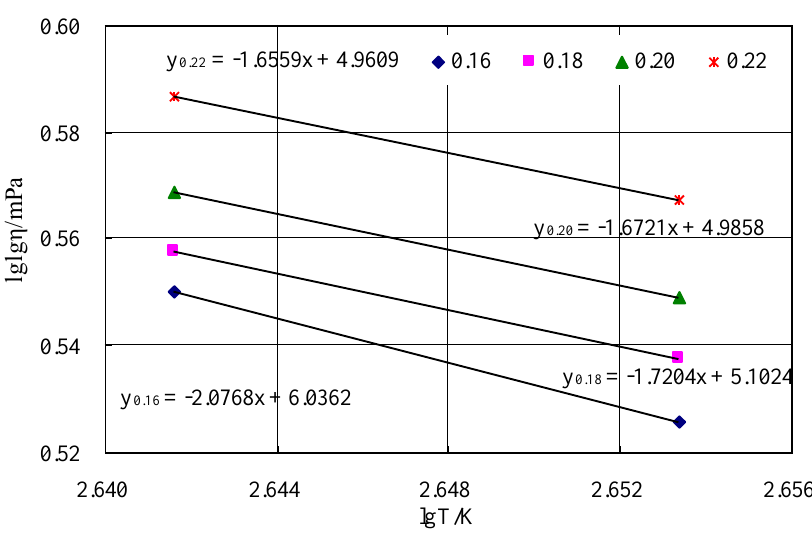
Figure 2. Viscosity–temperature curves of the CRMB binder. Figure 2. Viscosity – temperature curves of the CRMB binder.